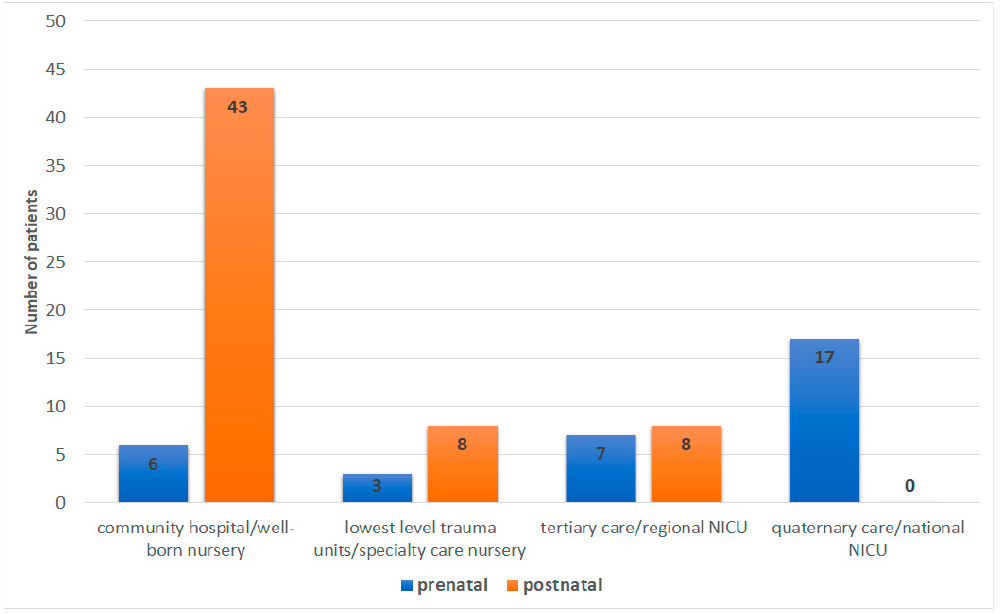
Figure 2. Difference in outcomes between prenatal and postnatal IAA detection. See Supplementary File S1 for complete details of the